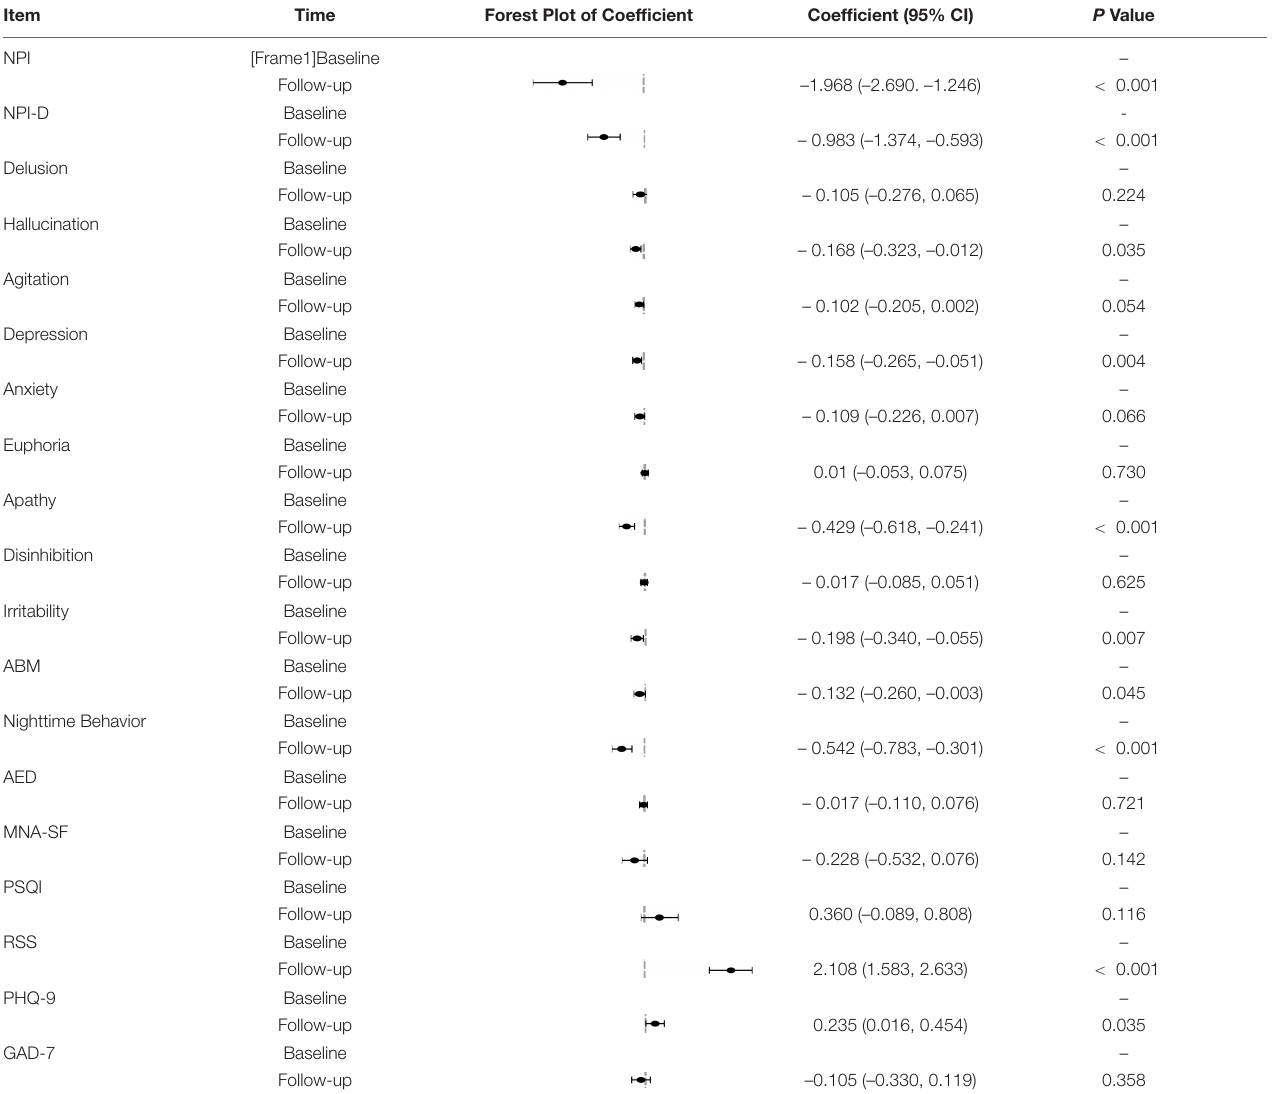
TABLE 3 | Generalized estimation equation for mixed effects on each evaluative